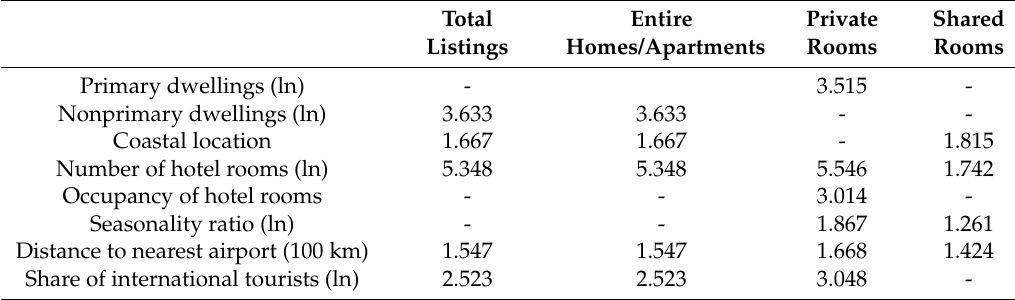
Table A9. Variance inflation factors for final models for tourist areas/sites (N =